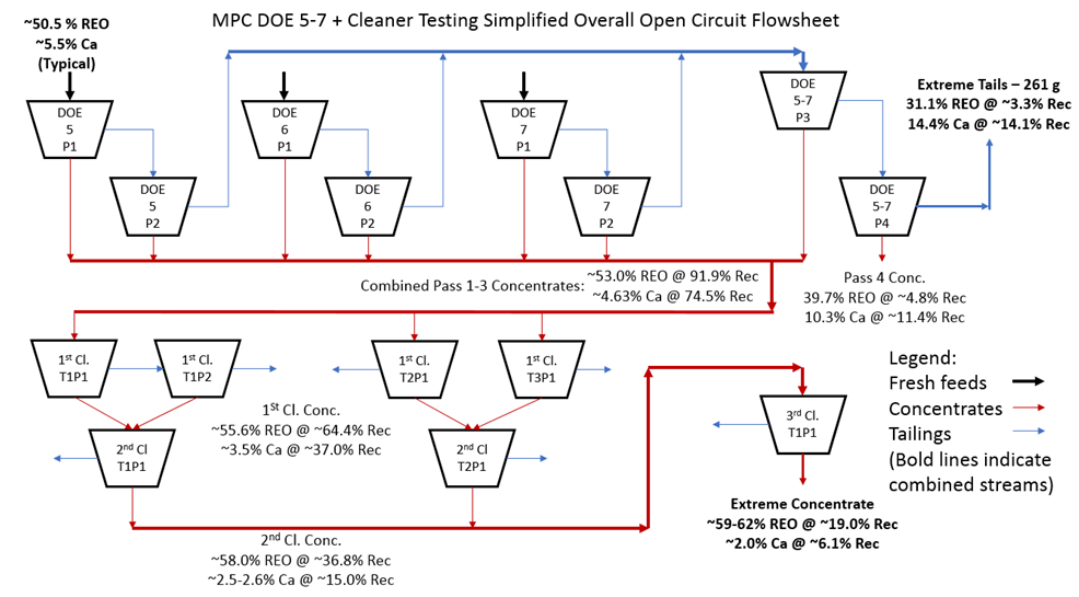
Figure 11. Overall flowsheet for MPC UF Falcon REO recovery and grade maximization testing programs. The overlaid values represent the estimated selected cumulative performance.